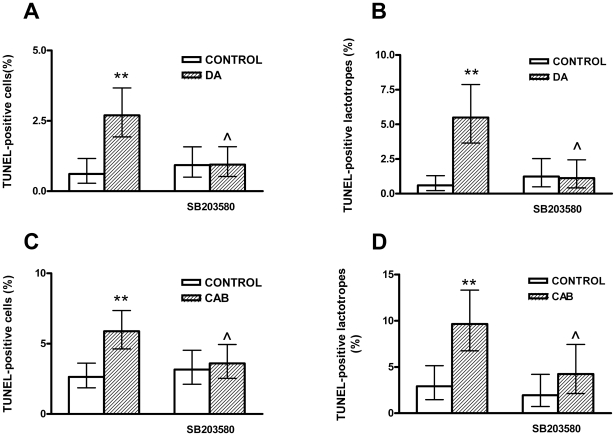
A p38 MAPK inhibitor blocks the apoptosis of anterior pituitary cells induced by D2R activation.Anterior pituitary cells were cultured with E2 (1 nM) for 48 h. Then the cells were preincubated with SB203580 (1 µM), a p38 MAPK inhibitor, for 30 min and then incubated with DA (1 µM, A and B) or CAB (1 µM, C and D) in the presence or absence of SB203580 for 4 h. Each column represents the percentage of TUNEL-positive cells ± CI (>2,000 cells/group, A, C) or the percentage of TUNEL positive lactotropes ± CI (>500 cells/group B, D). Data from at least two separate experiments were analyzed by χ2. ** p<0.01 vs respective control without DA or CAB. ∧ p<0.05 vs respective control without SB203589.